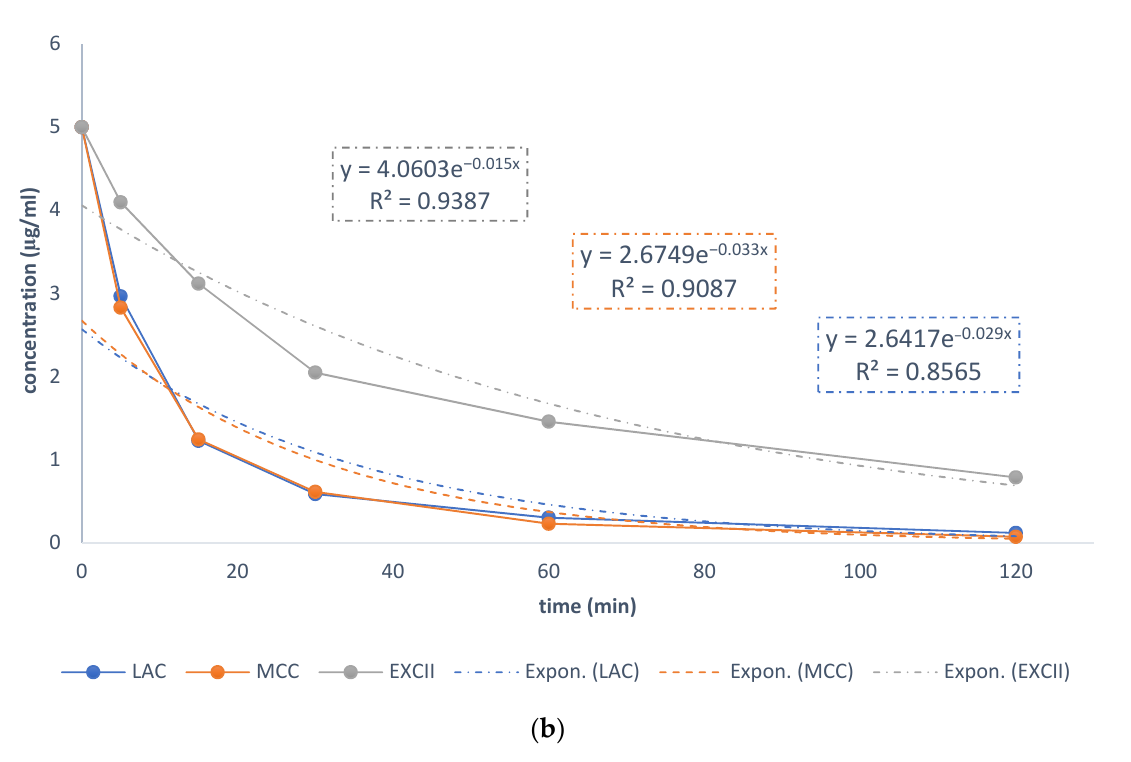
Figure 4. Kinetics of pantoprazole degradation in ( a ) tested dissolution media and dosing liquids; ( b ) medium pH 1.2 from compounded capsules F4, F5 and F6.